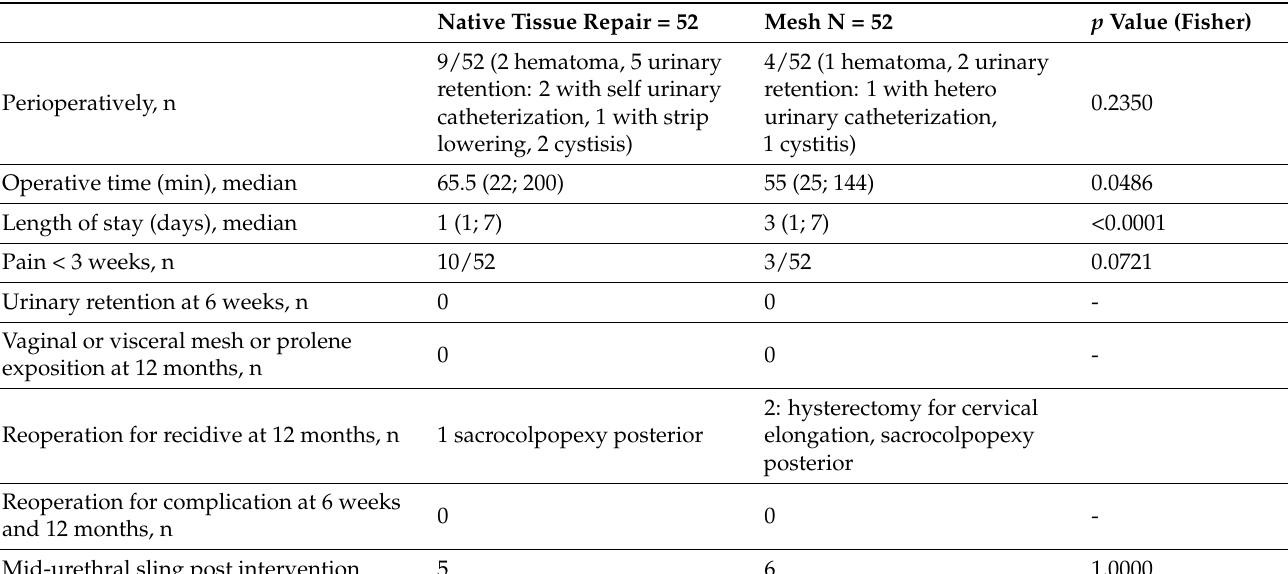
Table 3. Perioperative complications and